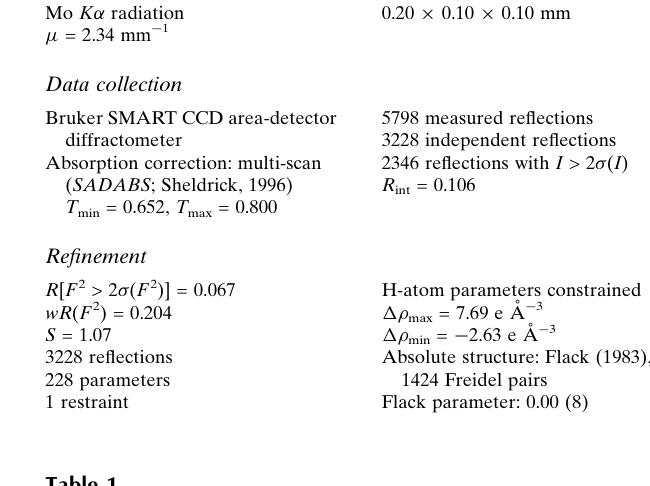
Hydrogen-bond geometry (A˚ , (cid:2)